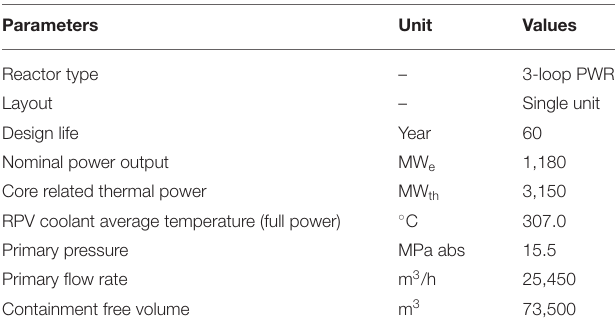
TABLE 1 | HPR1000 main technical parameters (General Nuclear System Ltd., 2018a).